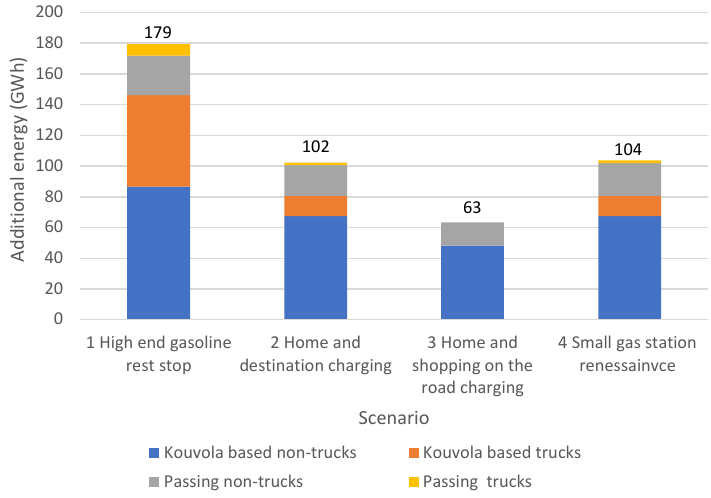
Figure 5. Summary of additional energy in different scenarios, divided according to the traffic category.